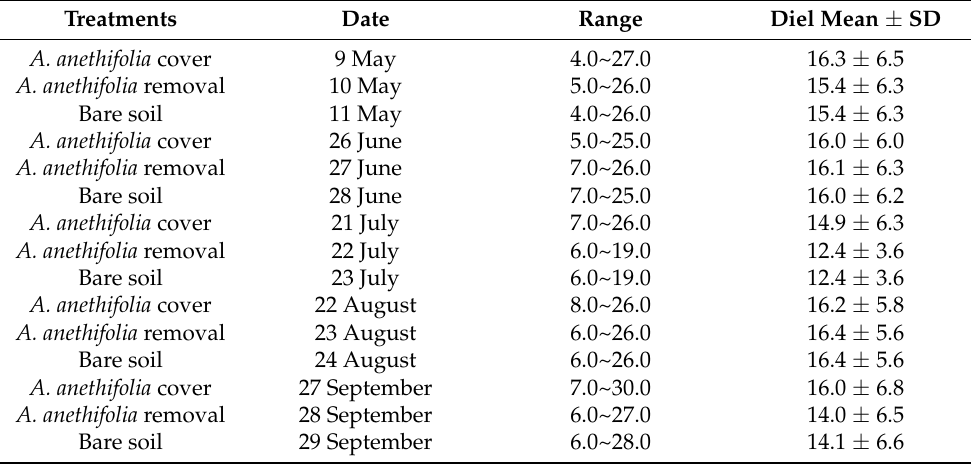
Table 1. Summary of gaseous elemental mercury concentrations (ng · m − 3 ) for the diel in 2018 ( n = 288).